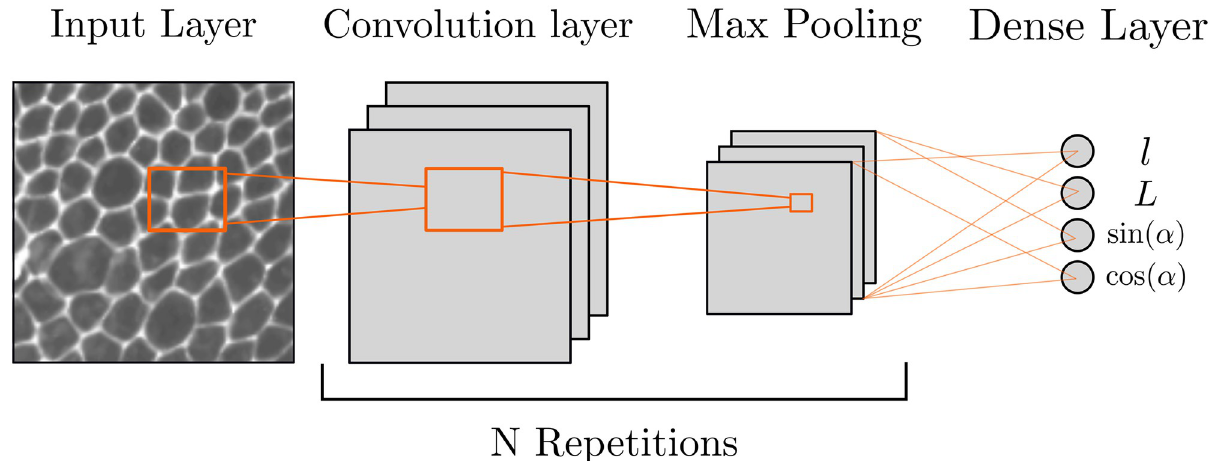
Fig 3. Schematics of the networks’ architecture. Models are based on the repetition of convolutional and max pooling layers. The dropout layers are not represented to help visualization. The four neurons of the final dense layer each correspond to one of the model’s targets.